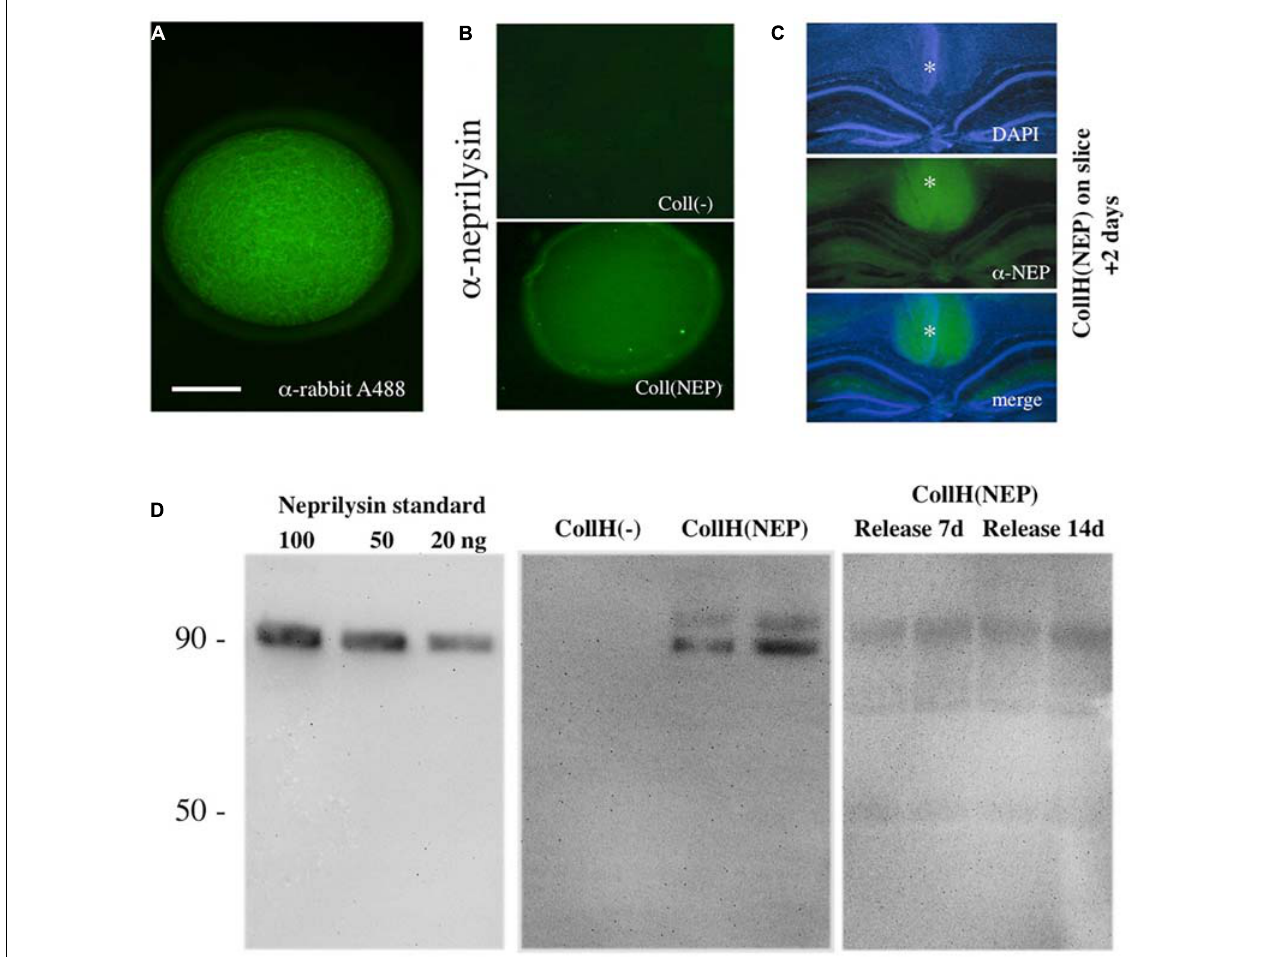
FIGURE 1 | Characterization of neprilysin-loaded hydrogels. A collagen hydrogel can be visualized under the fluorescence microscope after loading with a rabbit-Alexa 488 antibody (A) . Immunostainings with a neprilysin antibody (Alexa 488, green) shows successful loading of recombinant neprilysin into collagen hydrogels, compared to a negative hydrogel (B) . When neprilysin-loaded collagen hydrogels were loaded onto slices (as indicated by a *), incubated for 2 days and then fixed and stained for neprilysin, the hydrogels (middle, Alexa-488, green fluorescent) were clearly visible above the DAPI-counterstained (blue florescent, upper panel) hippocampal formation (C) . Western Blot Analysis shows detection of neprilysin with a detection limit of at least 20 ng/lane with a size of approx. 90 kDa (D) . Collagen hydrogels loaded with [CollH(NEP)] or without [CollH( − )] neprilysin show successful loading in hydrogels (D) . Release experiments show that very low amounts of neprilysin are released into the medium after 7 or 14 days (D) . Scale bar in (A) = 600 µ m (A) , 800 µ m (B) , and 1400 µ m (C)